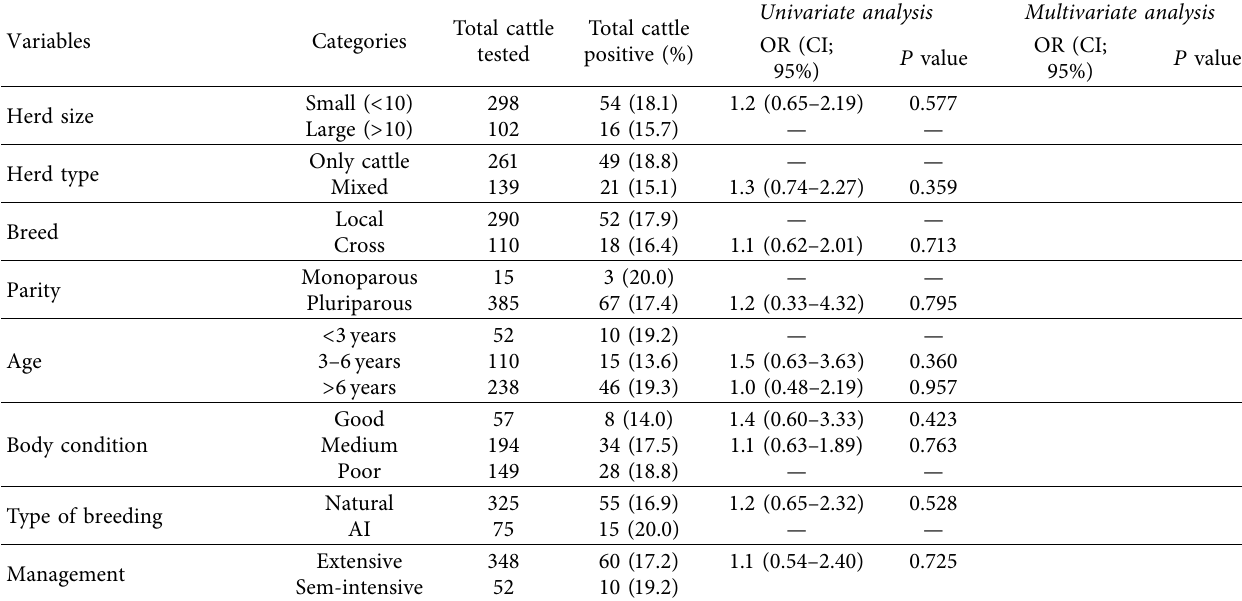
Table 3: Te efect of potential risk factors for cattle abortion in the study